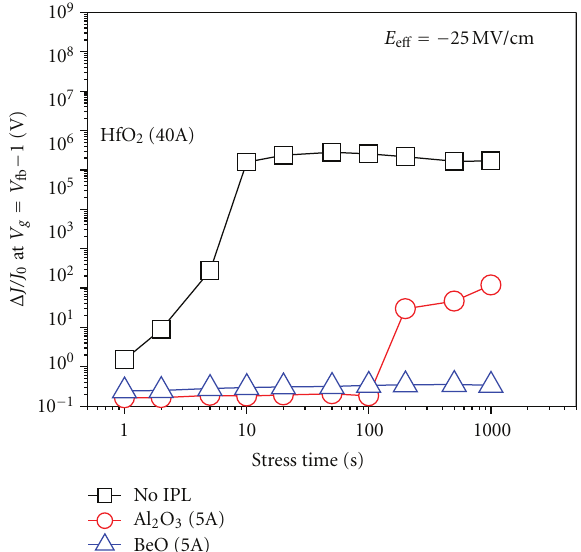
Figure 7: NMOSFETs inversion capacitance for three di ff erent gate stacks.